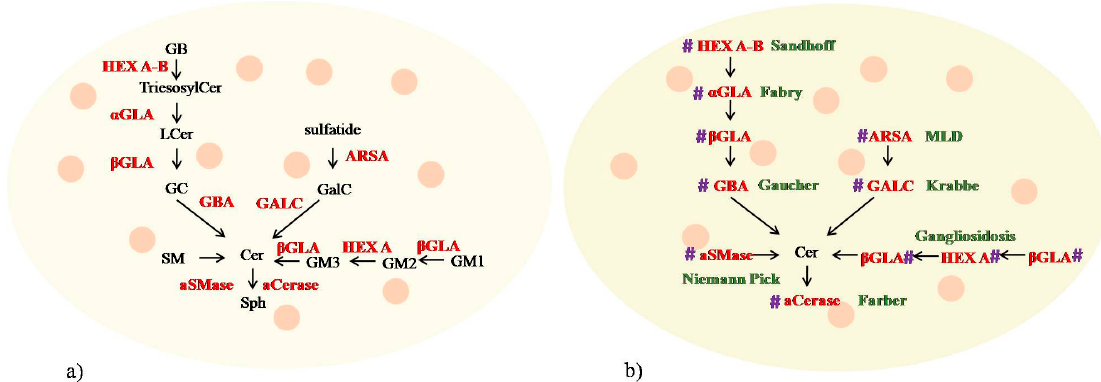
Figure 3. Ceramide metabolism in lysosome and sphigolipidoses. ( a ) ceramide production and utilization; ( b ) gene defects and pathological disorders. Enzymes are reported in red and diseases in green. Description in the text. aCerase, acid ceramidase; aSMase, acid sphingomyelinase; ARSA, arylsulfatase; Cer, ceramide; GB, globoside; GC, glucocerebroside; GalC, galactocerebroside; GALC, galactocerebrosidase; GBA, glucocerebrosidase; GLA, galactosidase; GM, monosialoganglioside; Hexa, hexosoaminidase; LCer, lactosylceramide; SM, sphingomyelin; Sph, sphingosine.